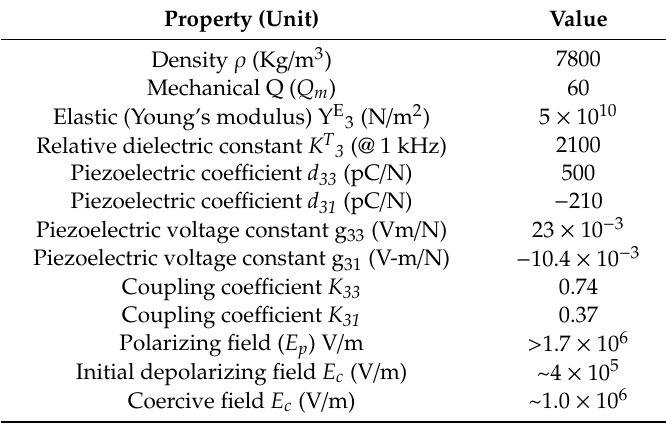
Table 1. Physical and electrical properties of the piezoelectric material.